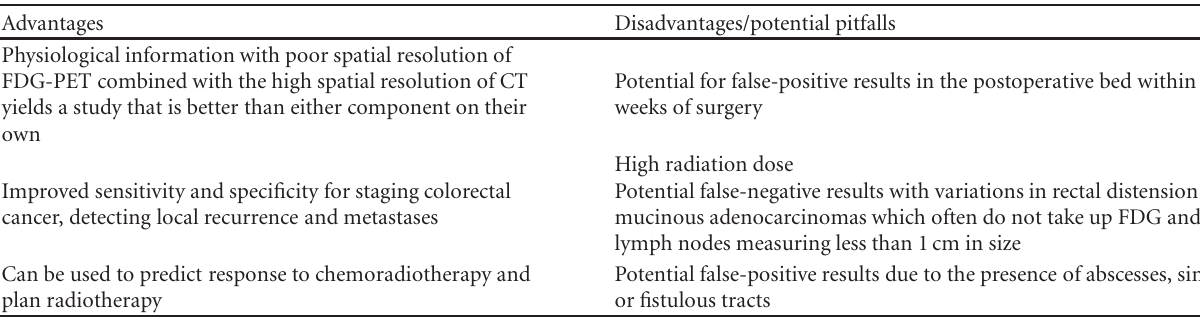
Table 5: Advantages and disadvantages/pitfalls of combined